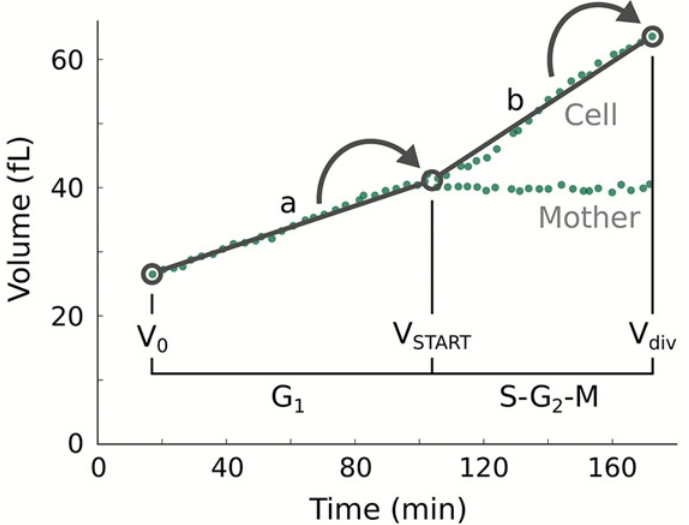
Fig 8. Unifying model for G 1 and G 2 cell size control. Cell size at the G 1 /S and the G 2 /M transitions is controlled in a growth rate dependent fashion with a functionally equivalent mechanism. Cell size at START (V START ) is a function of the growth rate in G 1 (a), as recently shown [15]. Cell size at division (V div ) is a function of the growth rate in G 2 (b), as proposed here. Experimental data (green dots) is taken from [40].